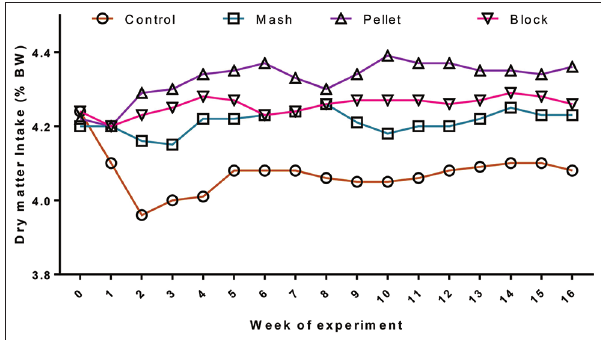
Figure-2: Dry matter intakes (%body weight) of the lambs-fed chopped, mash, pellet, and block form of rations during the growth trial.